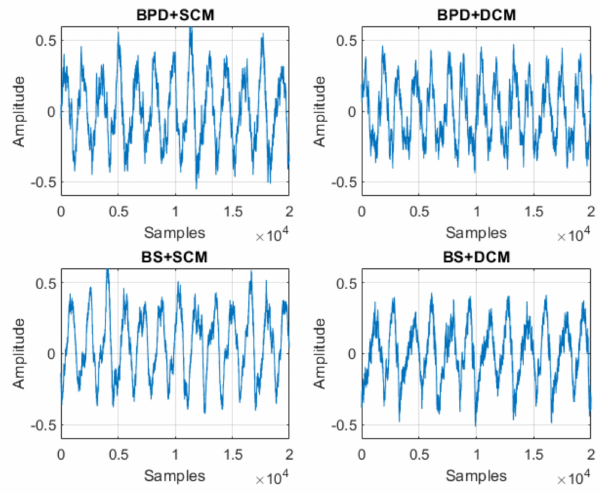
Figure 22. Samples of the studied signals—BPD + SCM, BPD + DCM, BS + SCM and BS +